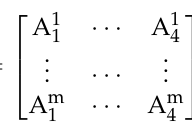
Figure 9. Flowchart of the data enhancement algorithms.